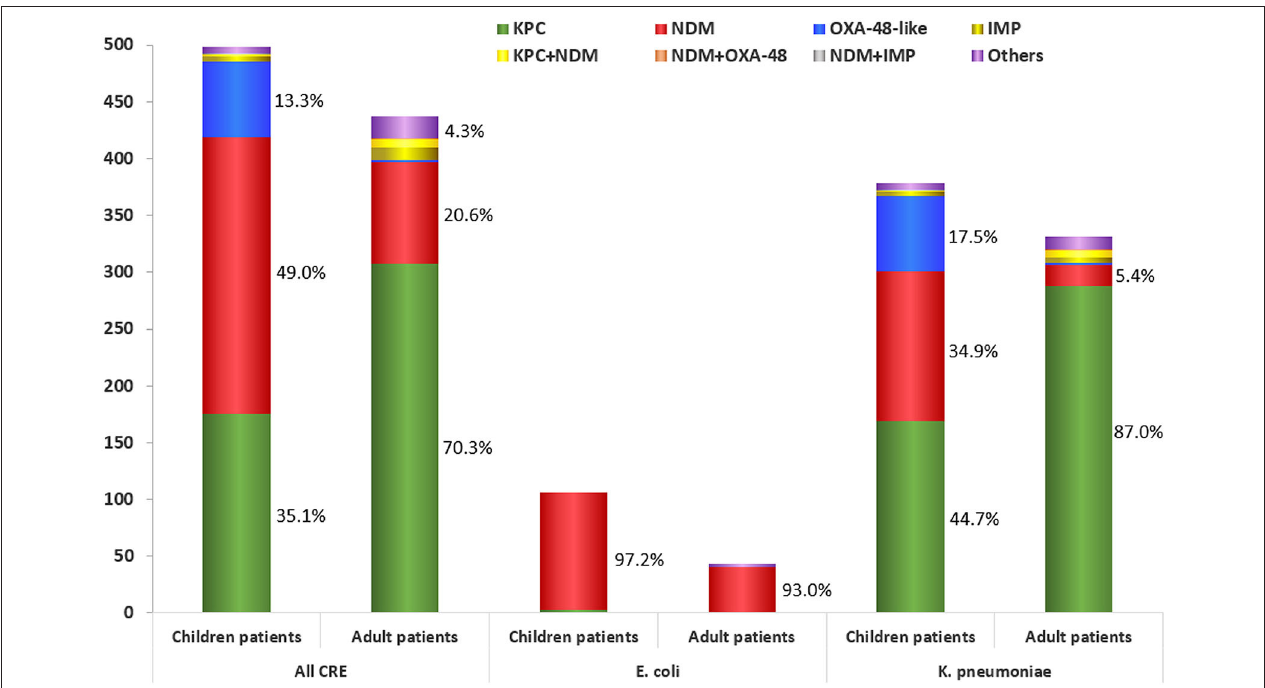
FIGURE 2 | Carbapenemase distribution among the carbapenem-resistant Enterobacteriaceae strains isolated from adult and children patients.